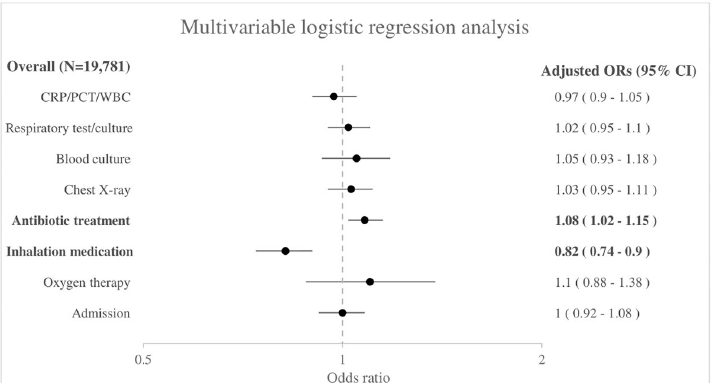
Fig 1. Association between sex and management for all febrile children presenting with respiratory symptoms (N = 19,781). Boys as reference group. Adjusted for age, triage urgency, ill appearance, tachypnea, tachycardia, hypoxia, work of breathing, duration of fever,